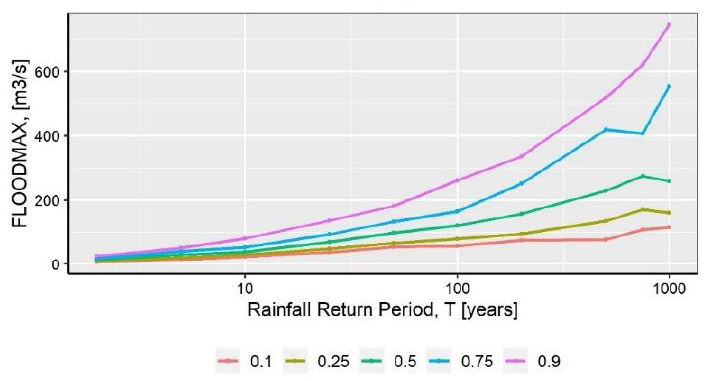
Figure 10. Probabilistic plots of simulated peak flow values at the outlet of Trachones stream.